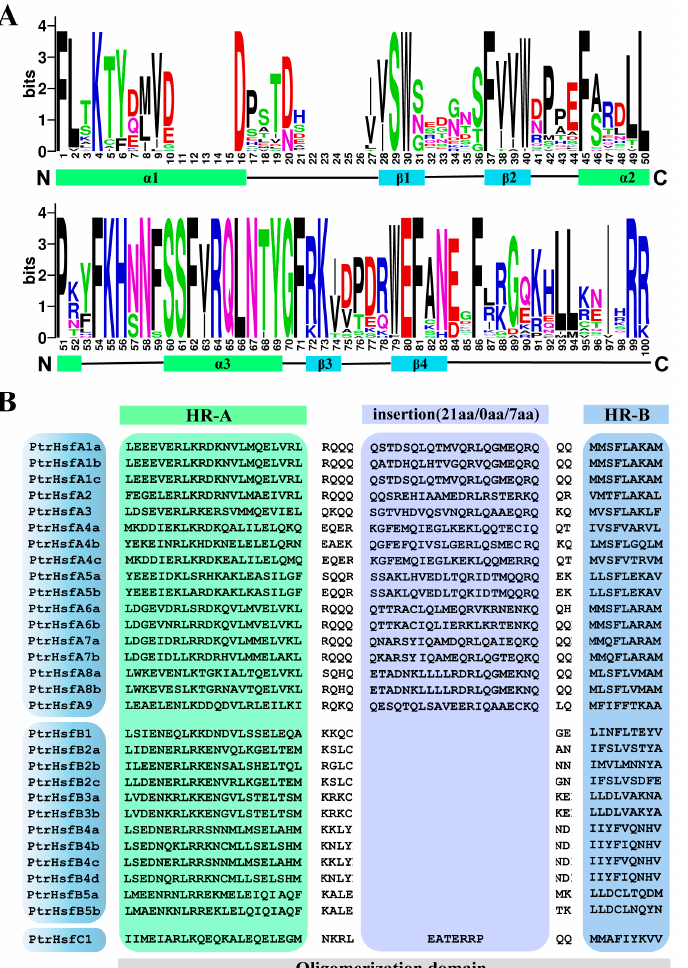
Figure 3. Visualization of the DNA binding domains and oligomerization domain of poplar HSF proteins. ( A ) DNA binding domains. The degree of conservation of each position sequence is indicated by the height of the letter pile at that position. ( B ) Oligomerization domain. The analysis of the physicochemical properties showed that the members of the pop- lar HSF family differed greatly in protein length, molecular weight, and theoretical isoe- lectric point (Table S2). These thirty proteins have an average length of 368.07 amino acids (188–522 aa) and an average molecular weight of 41.45 kDa (22.23–58.19 kDa). Among the various groups, the average length and molecular weight of the group A proteins (433.88 aa, 48.87 kDa) were significantly higher than those of group B (277.25 aa, 31.23 kDa) and group C (339 aa, 37.98 kDa). The theoretical isoelectric points of these proteins range be- tween 4.7 and 9.59, with values less than 7 for both the group A and C proteins, and a